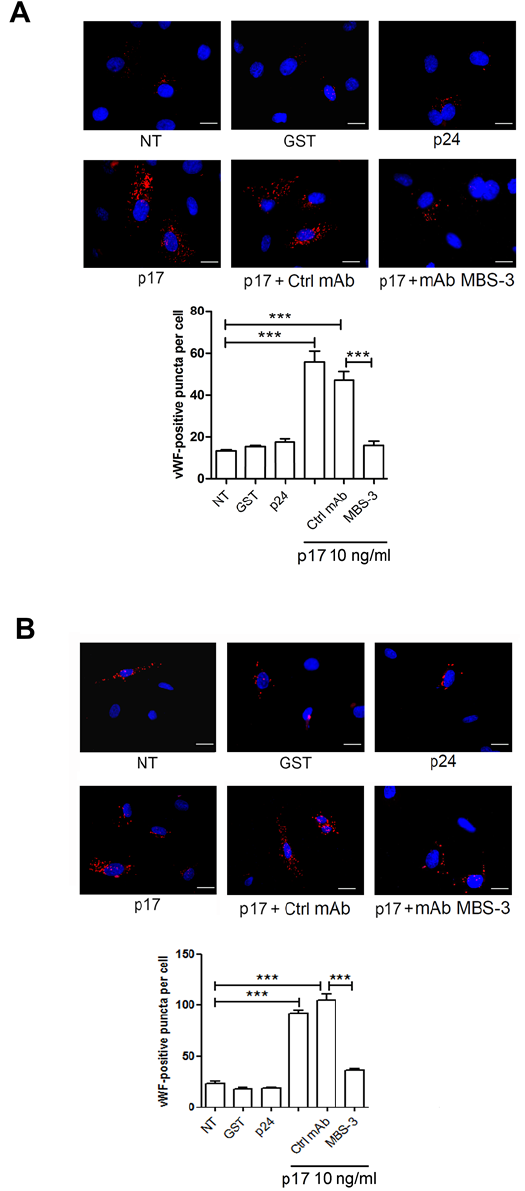
Figure 2. vWF accumulation in WPBs is specifically induced by p17. mCherry-vWF nucleofected HUVECs ( A ) and HMVEC-Ls ( B ) were serum starved for 16 h and then treated with 10 ng/mL of GST, p24 or p17 in complete medium. When indicated, cells were stimulated with p17 (10 ng/mL) after preincubation of the viral protein with 1 µg/mL of mAb to p17 (MBS-3) or unrelated control mAb (Ctrl mAb) for 30 min at 37 °C. The images display vWF signals in red and cell nuclei in blue. Scale bar, 10 μm. Red-positive punctate structures were counted in order to quantify the levels of WPBs. NT indicates not treated cells. Values reported for vWF positive structures are the mean ± SD of 3 independent experiments with similar results. Statistical analysis was performed by one-way ANOVA, and the Bonferroni post-test was used to compare data (*** p <